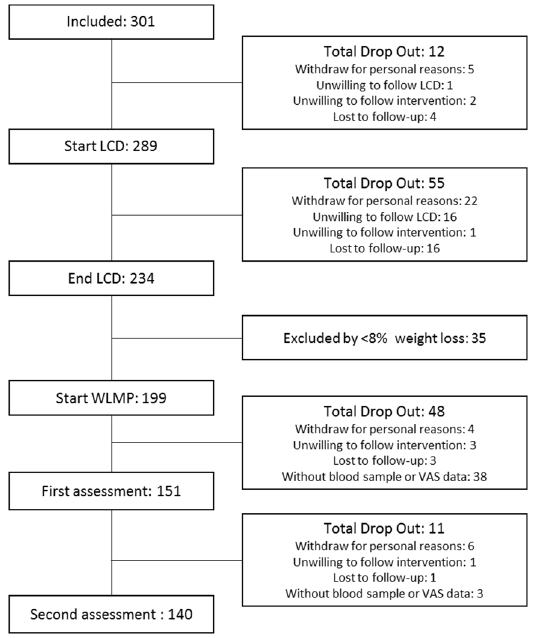
Figure 1. Flow-chart of the study.